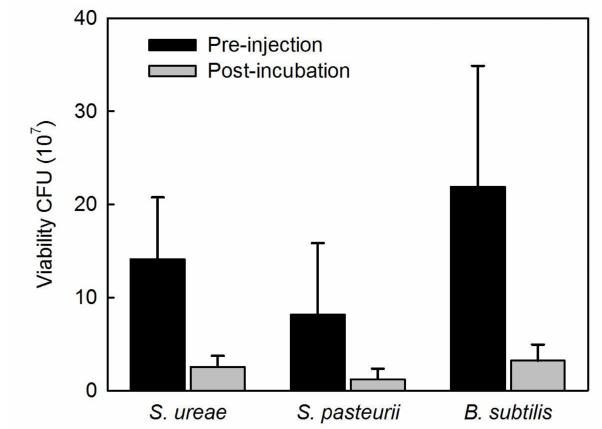
Figure 4. Microbial viability of treated sands before injection (black bars) and after incubation (gray bars) (SD, n =